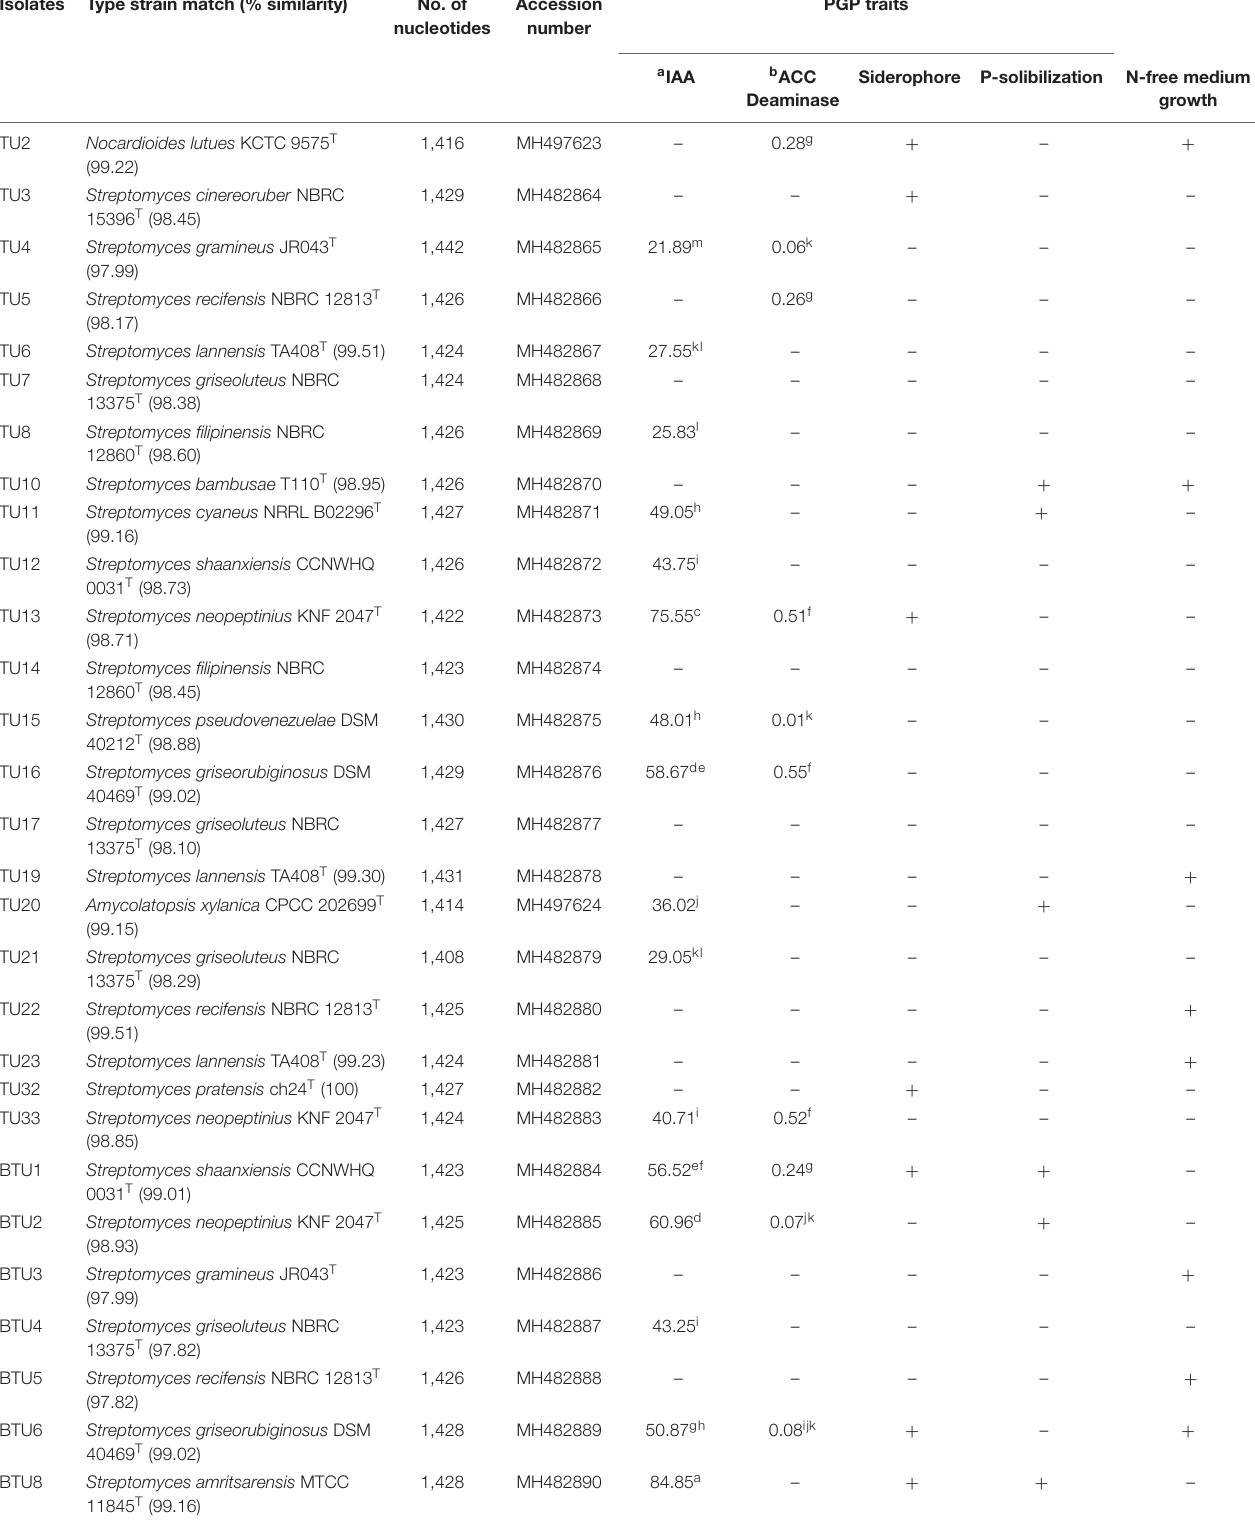
TABLE 1 | Identification and PGP characteristics of